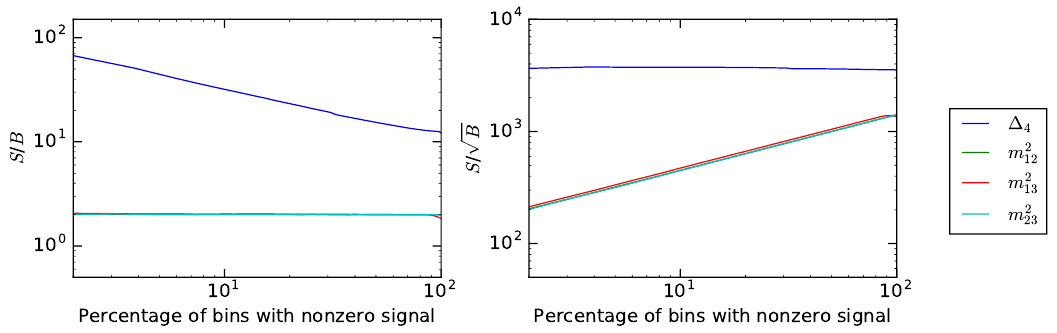
Figure 4 . Performance curves for (cid:1) 4 and the invariant mass variables using the S = B (left panel) and S = p B (right panel) metrics, with perfect energy resolution. See the main text for the way in which we construct these curves.